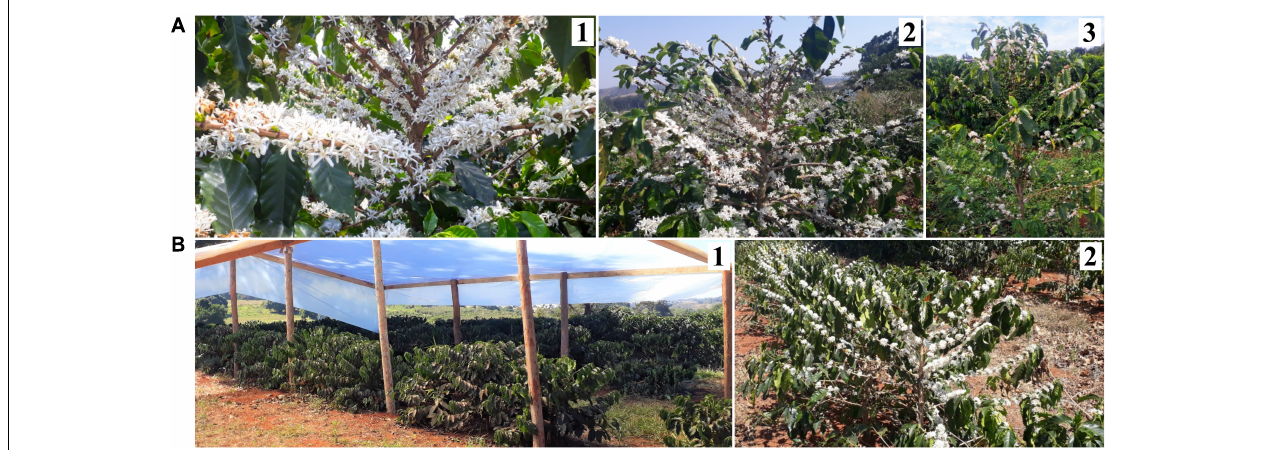
FIGURE 6 | Coffee anthesis in (A) Oeiras (1), Acauã (2), and Semperflorens (3) in field experiment I. (B) Non-flowering and flowering plants of Paraiso 2 coffee cultivar using treatments of Covered and Uncovered environment at the field experiment II.